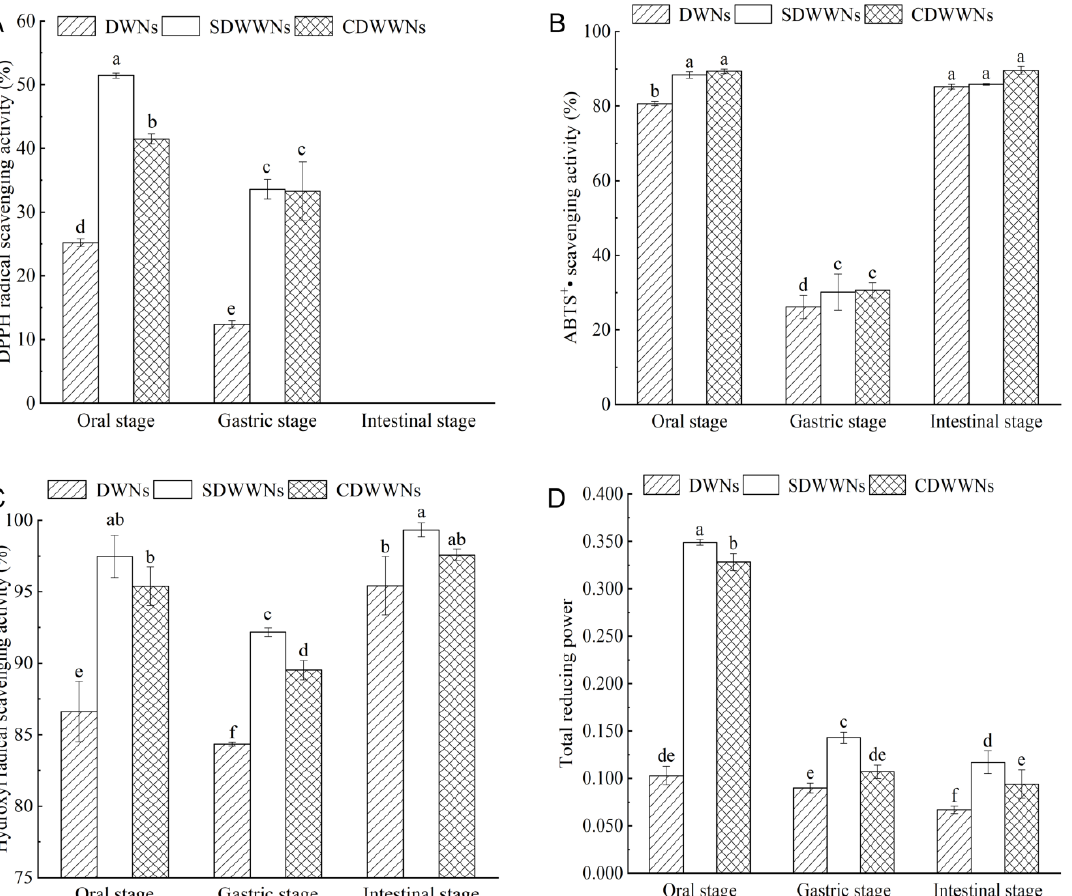
Figure 4. Antioxidant activity of the cooked noodles after the in vitro simulated digestion. A. DPPH radical scavenging activity; B. ABTS radical scavenging activity; C. Hydroxyl radical scavenging activity; D. Total reducing power. DWNs, dried wheat noodles; SDWWNs, stone-milled dried whole wheat noodles; CDWWNs, commercially dried whole wheat noodles. Different letters indicate significant differences in the same indicator data ( p < 0.05).